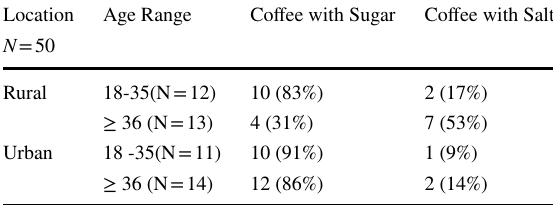
Table 3 Rural-Urban comparison of sugar use with coffee between different age groups